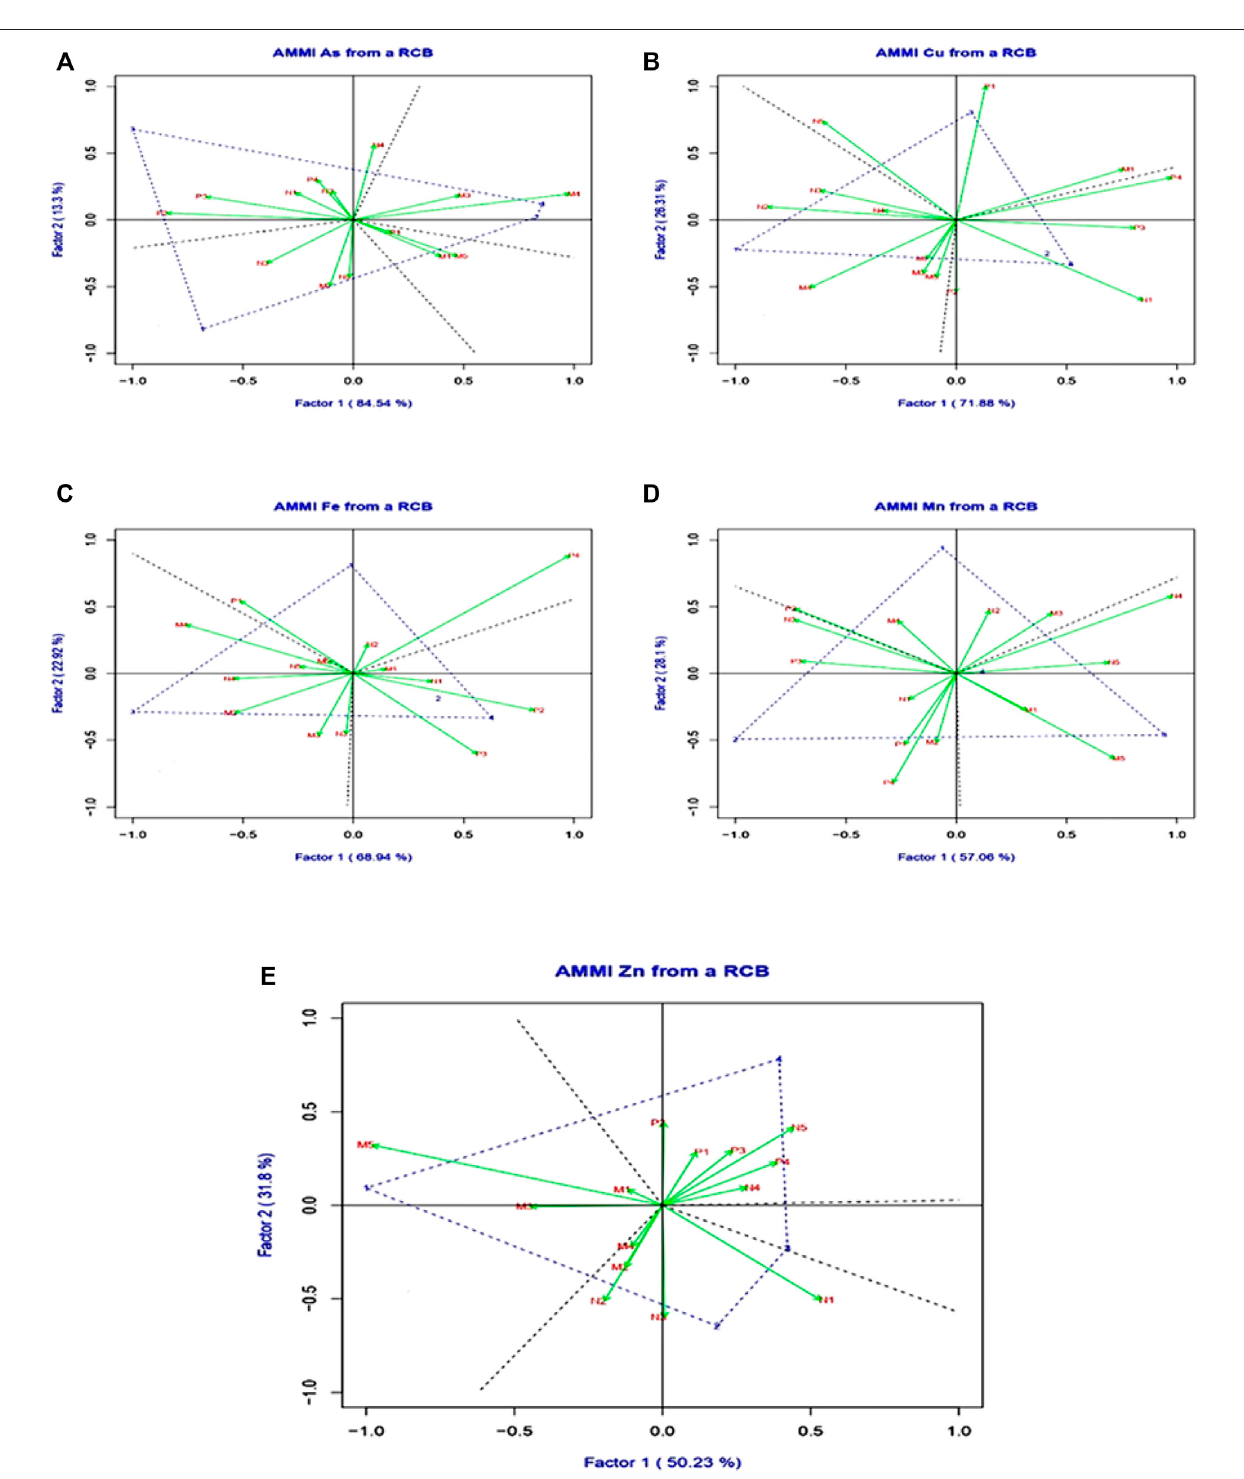
FIGURE2| Additivemaineffectsandmultiplicativeinteraction2biplotsforprincipalcomponents1and2(factor1andfactor2)forselectedmetalandmetalloids (A) As, (B) Cu, (C) Fe, (D) Mn, and (E) Zn. M1, Beldanga-I; M2, Beldanga-II; M3, Islampur; M4, Reginagar; M5, Domkol; N1, North Chandamari; N2, Porar Math; N3, Bamonbelia; N4, Kurumbelia; N5, Paschimer Math; P1, Guma; P2, Bira; P3, Prithiba; P4, Badarhat.